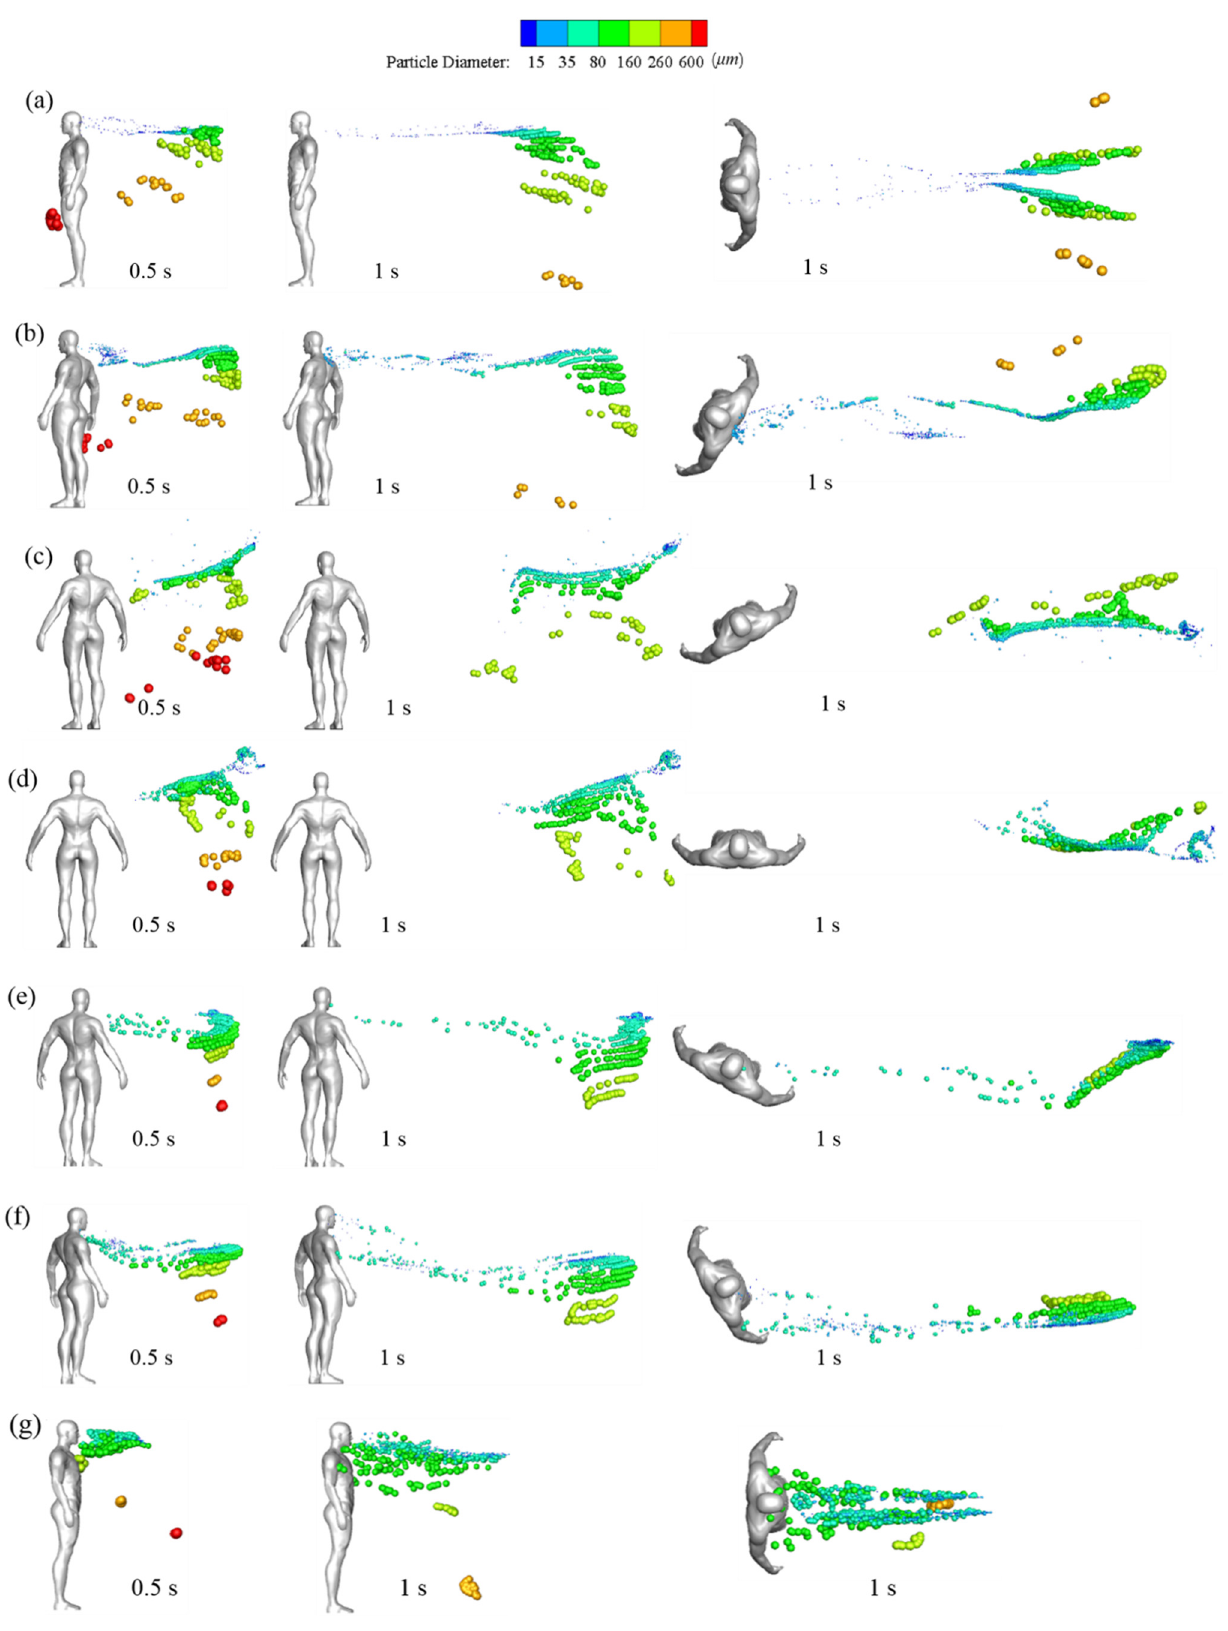
Figure 11. Side and top views of particulate distributions at various times in different wind directions: ( a ) 0°, ( b ) 30°, ( c ) 60°, ( d ) 90°, ( e ) 120°, ( f ) 150°, and ( g ) 180°.